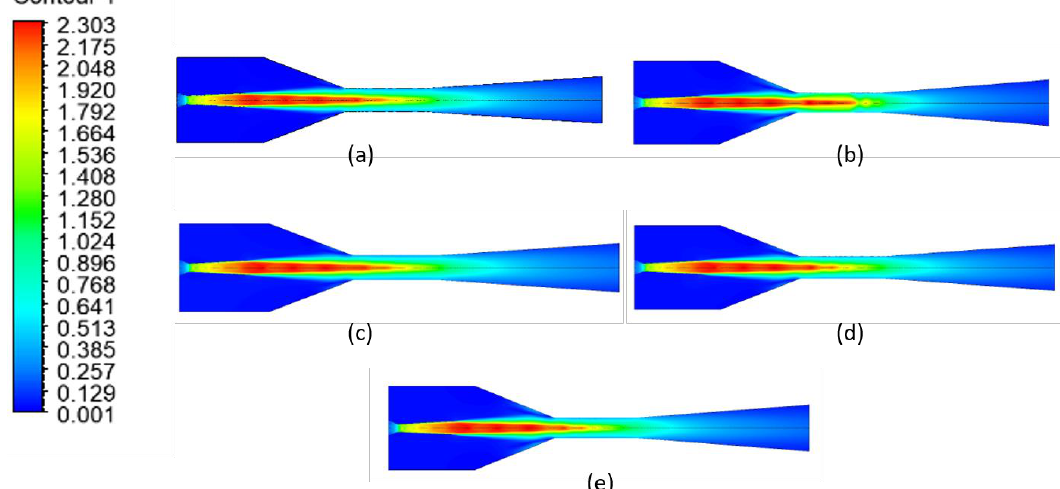
Figure 9. Mach number contours ( a ) AD Geometry P e = 0.047 MPa, P g = 0.538 MPa; ( b ) AA Geometry P e = 0.047 MPa, P g = 0.538 MPa; ( c ) AD Geometry P e = 0.04 MPa, P g = 0.465 MPa; ( d ) AC Geometry P e = 0.04 MPa, P g = 0.465 MPa; and ( e ) AB Geometry P e = 0.04 MPa, P g = 0.465 MPa.